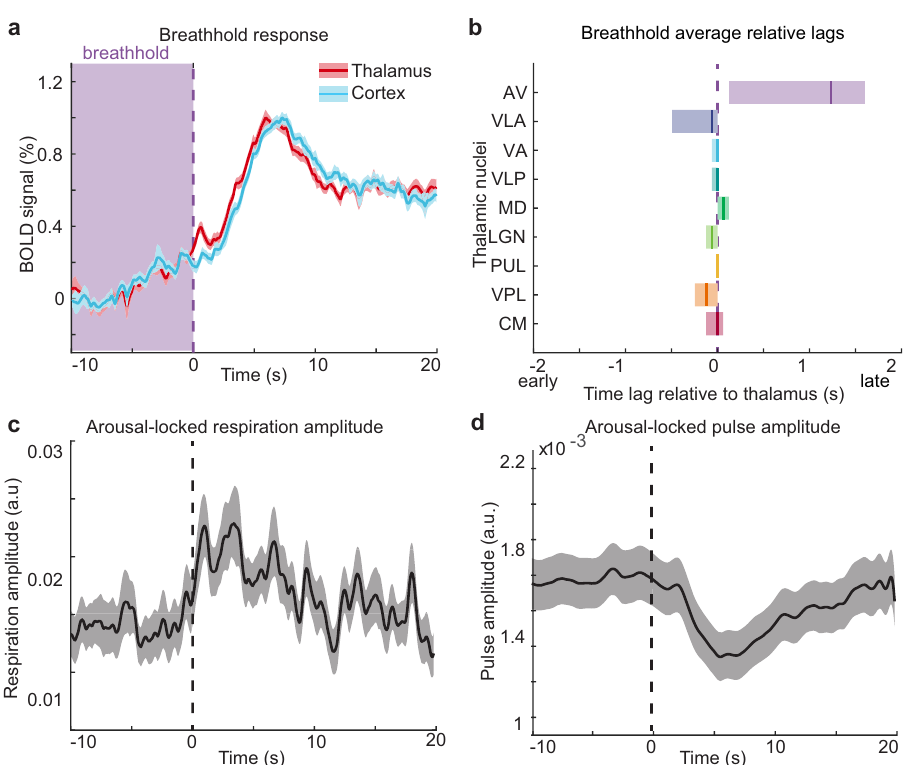
Mean lag (solid line) and 95% con fi dence interval (shading) were calculated by the same method as Fig. 4d. Purple dashed line represents a zero-lag relative to the whole thalamus. c Respiration amplitude increases at behavioral arousal (dashed line). Data were presented as mean values, and shading is the standard error. d Amplitude of the pulse signal decreases after behavioral arousal. Shading is a standard error. Source data are provided in the “ Fig. 5 Source Data ” fi le.